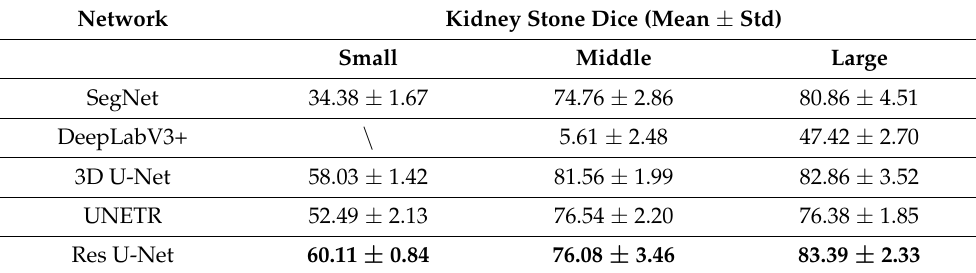
Table 3. The performances of different networks by kidney stone